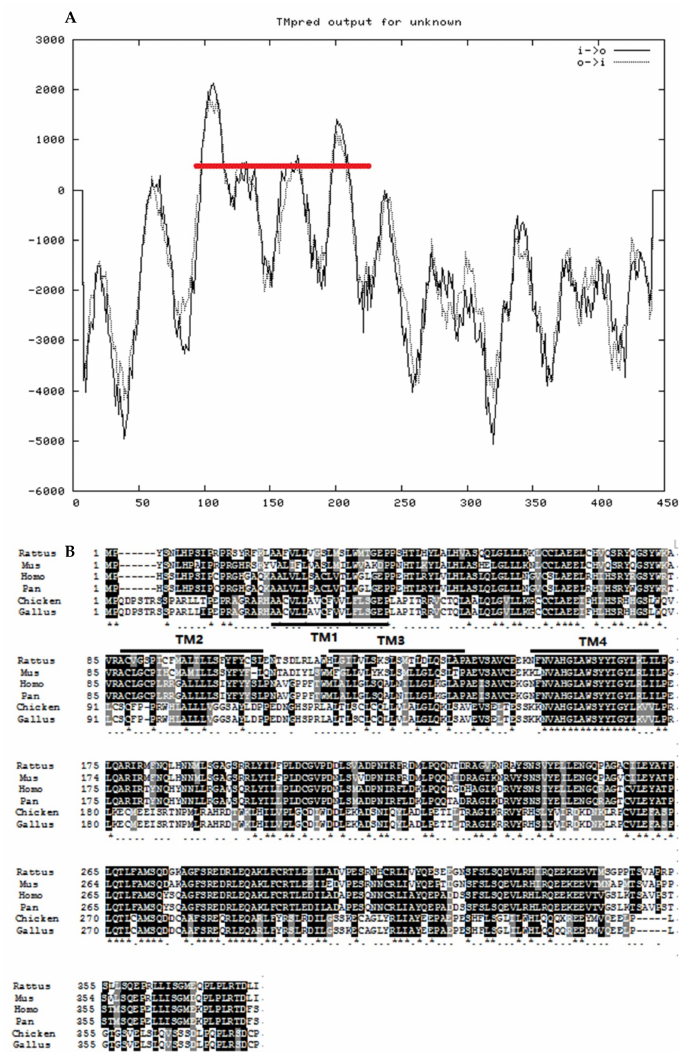
Figure 2. Structures and alignment of predicted amino acid sequence for chicken STING . ( A ) Secondary structure and transmembrane tendency prediction of STING . The red line means transmembrane domain. ( B ) Multiple alignment of STING amino acid sequences from different